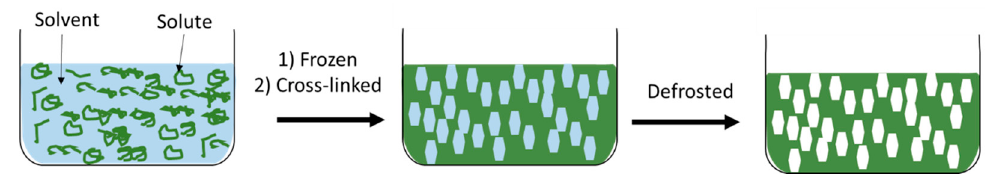
Figure 2. Cryogel synthesis: the polymer solute solution is frozen, encouraging a phase separation with the solvent. It is then cross-linked with an initiator to form the polymer, and then defrosted to expose the porous structure.